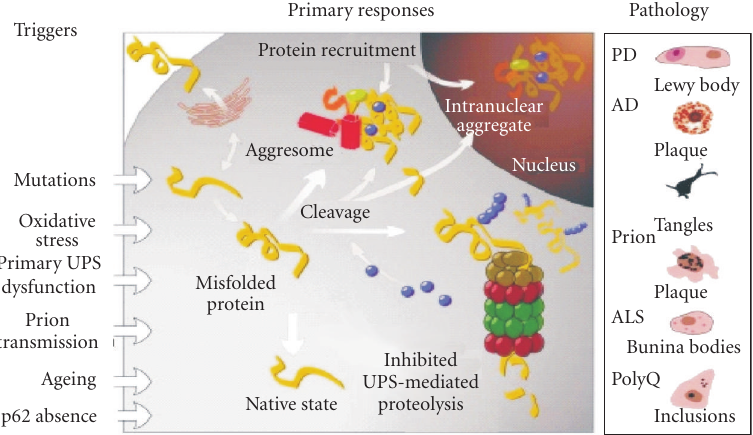
Figure 8: The UPS and pathogenesis of neurodegeneration (see